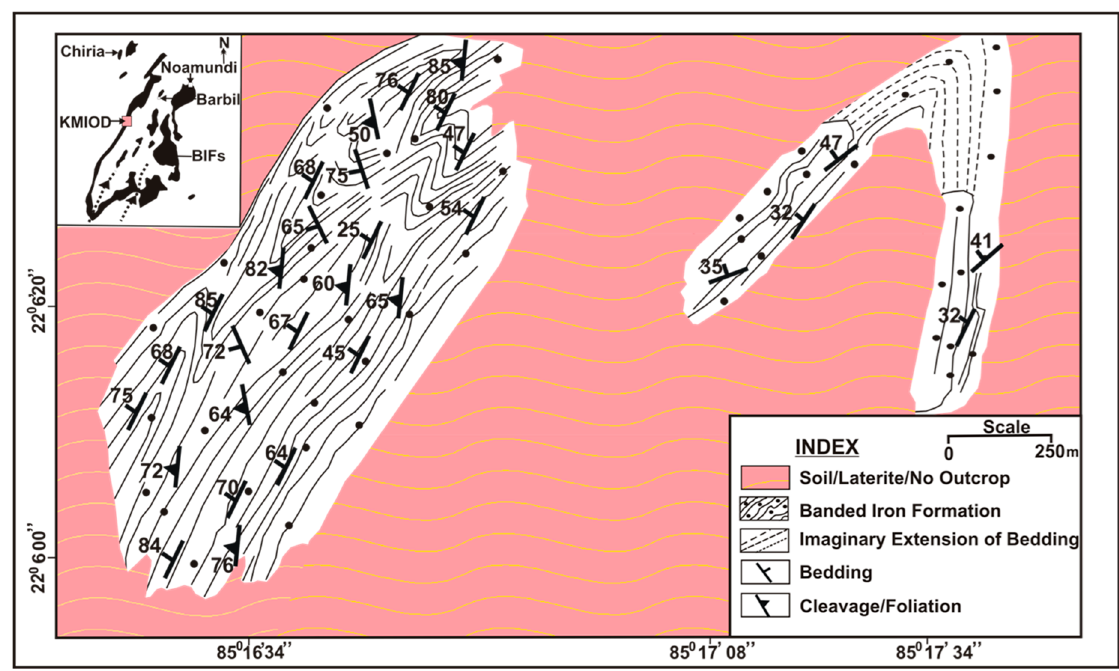
Figure 9. Structural map in and around KMIOD which forms a part of the western limb of the horse shoe-shaped synclinorium within Bonai-Keonjhar iron ore basin.